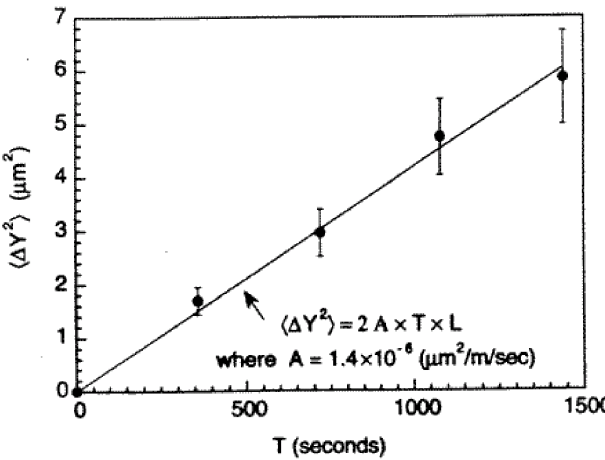
FIG. 23. Variance of the vertical laser spot movement in the SLAC laser system (from Ref.